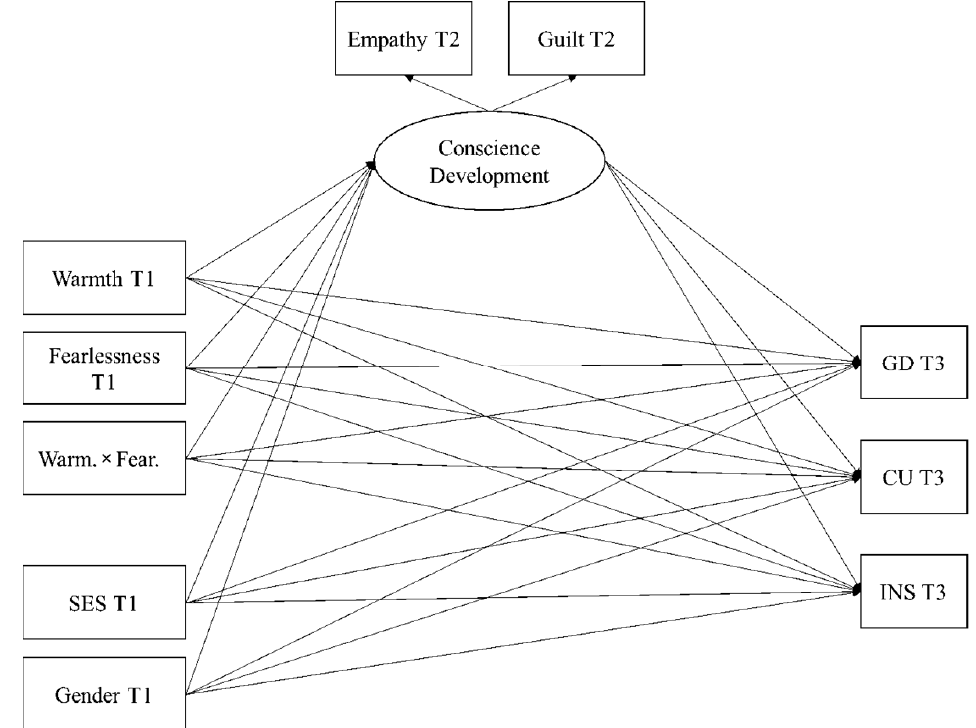
Figure 2. Structural equation model computed to test conditional indirect effects in the current